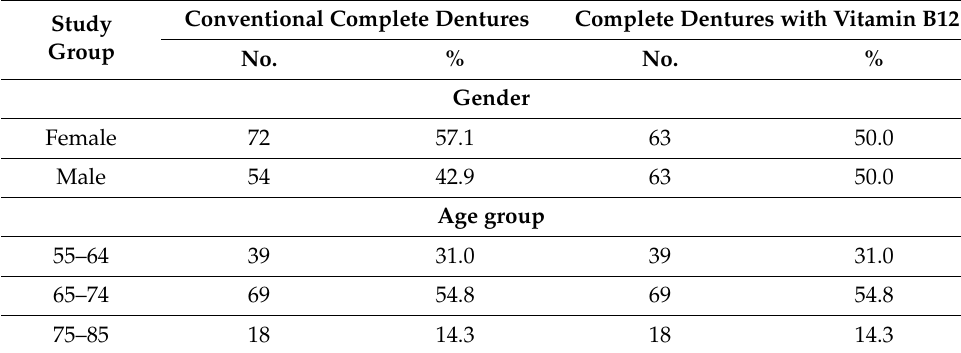
Table 1. Demographic features of the study